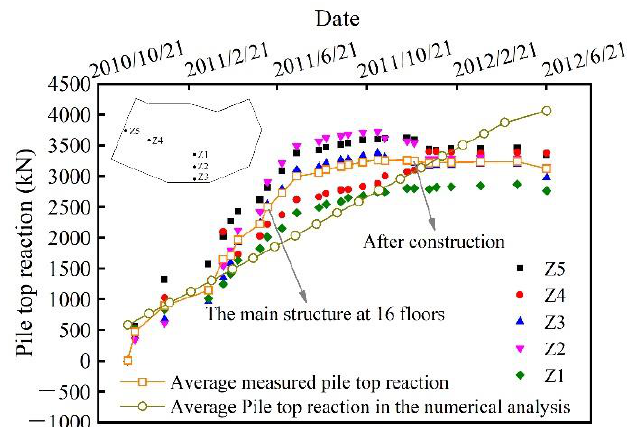
Figure 21. Curve of pile top reaction variation with time.